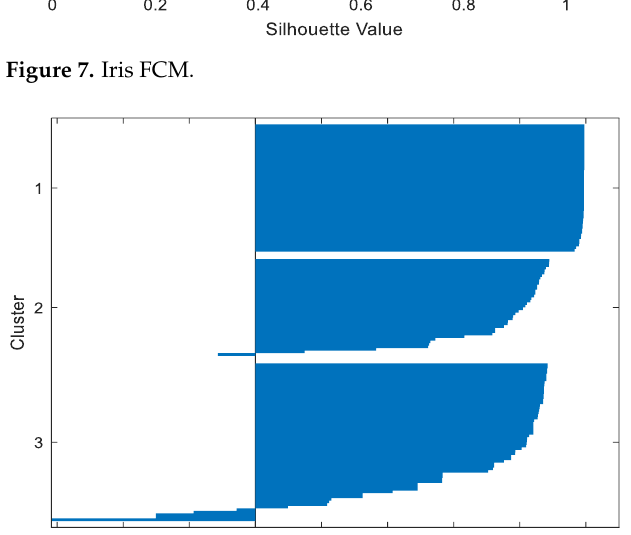
Figure 8. Iris Figure 8. Iris GMM. Figure 8. Iris GMM.